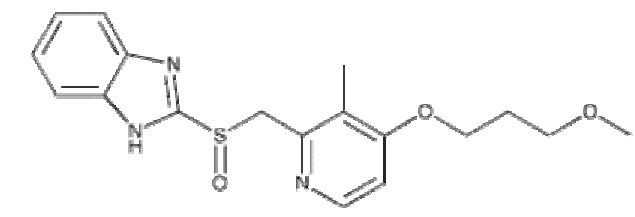
Figure 1. Chemical structure of